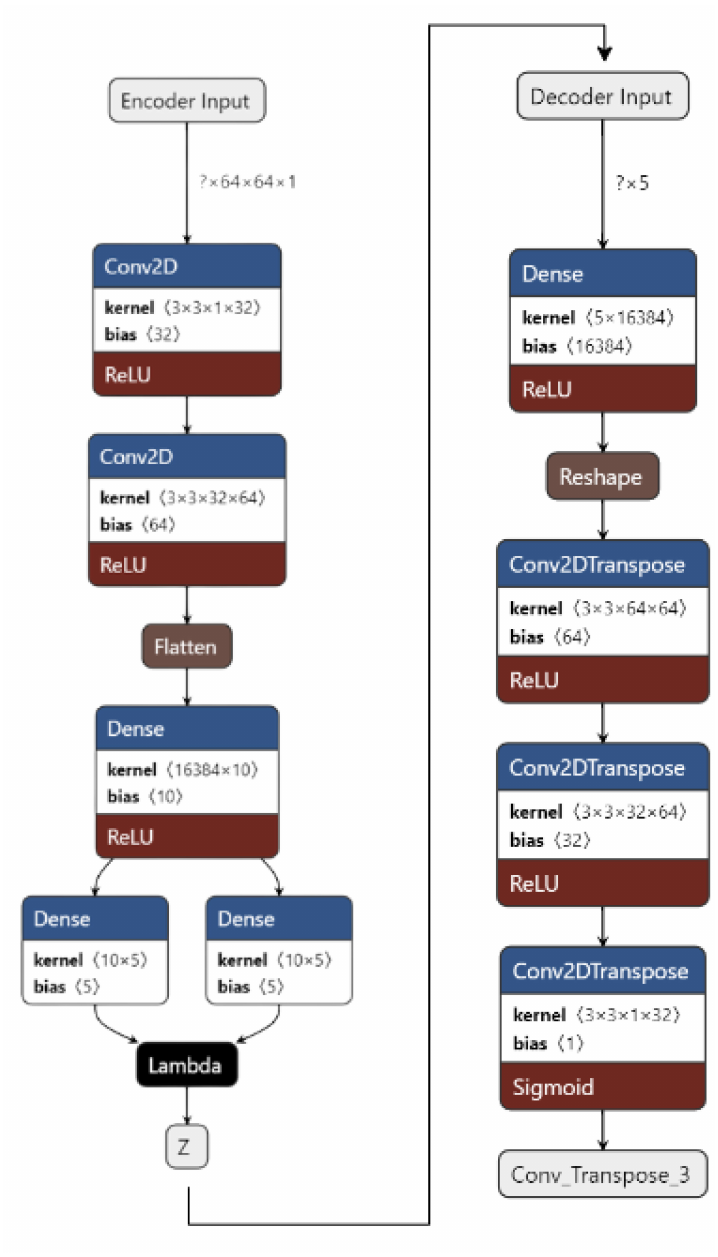
Figure 4. VAE for the proposed